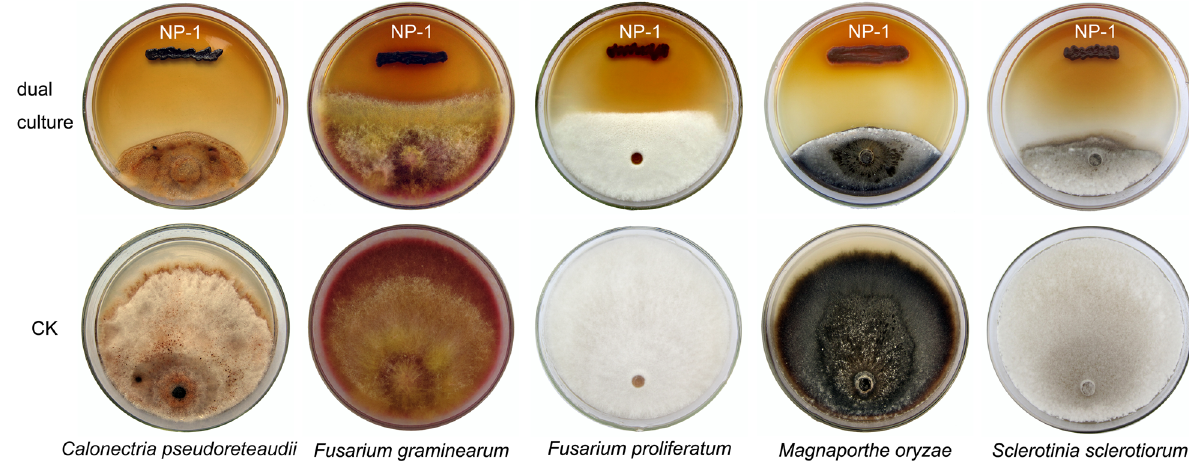
Figure 5. Antagonistic interaction between Pseudomonas eucalypticola NP-1 T and selected phytopathogenic